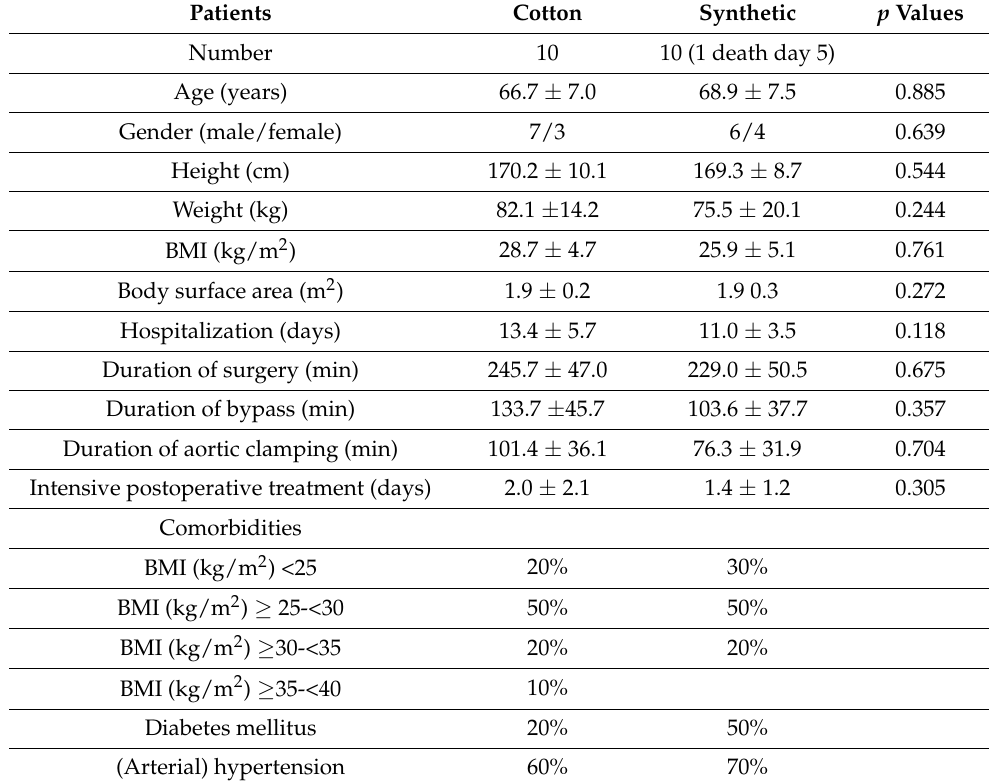
Table 2. Data of patients where cotton ( n = 10) or synthetic ( n = 10) swabs were used during the surgery. Data are presented as mean ± SD or percentage of patients per group. Differences between groups were assessed by Student’s t